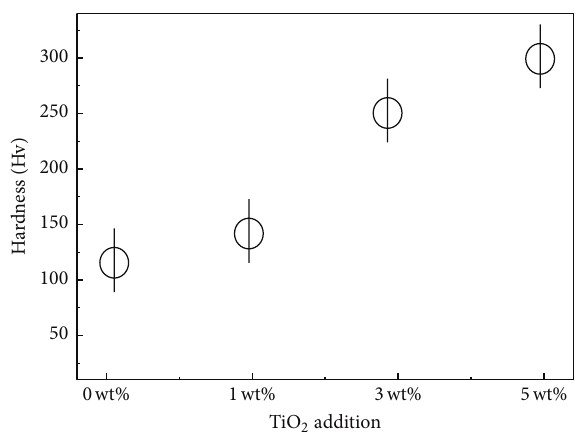
Figure 4: Vickers hardness of the ZrO 2 ceramics with addition of 0, 1, 3, and 5 wt% TiO 2 contents.